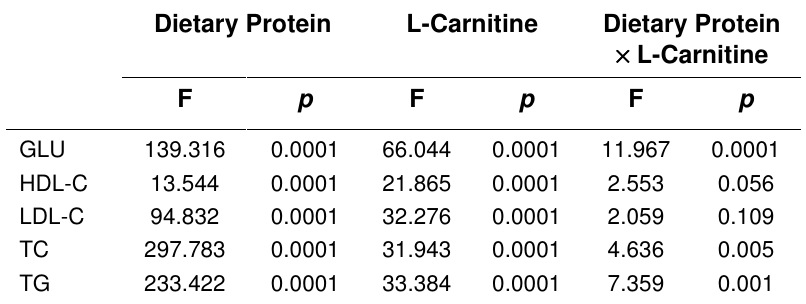
Results of ANOVA of the Effects of Dietary Protein and L-Carnitine on Blood Sugar and Lipid Contents of the New GIFT Strain of Juvenile Nile Tilapia Dietary Protein L-Carnitine Dietary Protein ×××× L-Carnitine F p F p F p GLU 139.316 0.0001